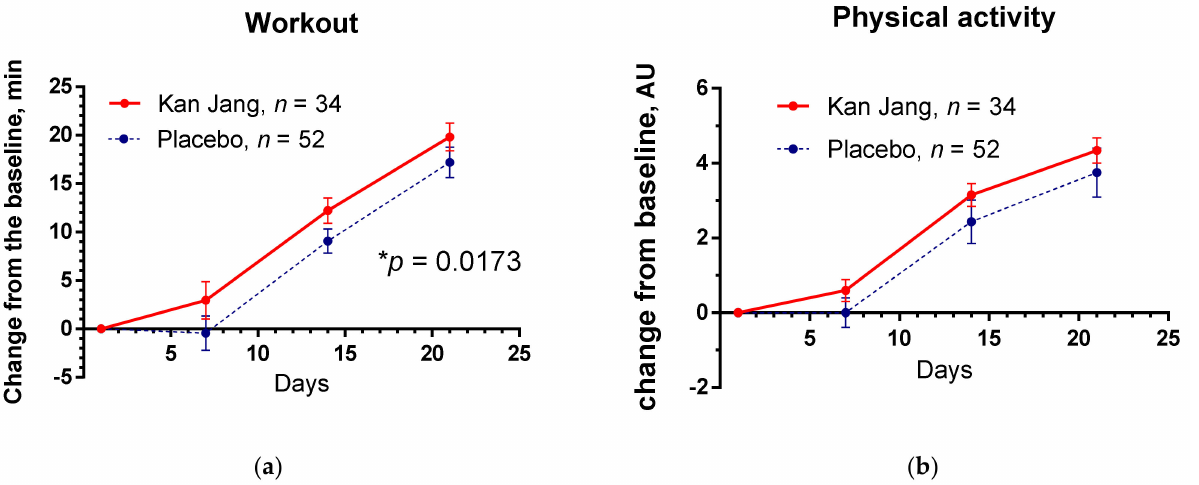
Figure 9. Between-groups comparison of the changes from the baseline of ( a ) physical perfor- mance/workout time (in min) and ( b ) the overall physical activity of patients in group A (Kan Jang) and group B (placebo) over the time from Day 1 to Day 21. * p <